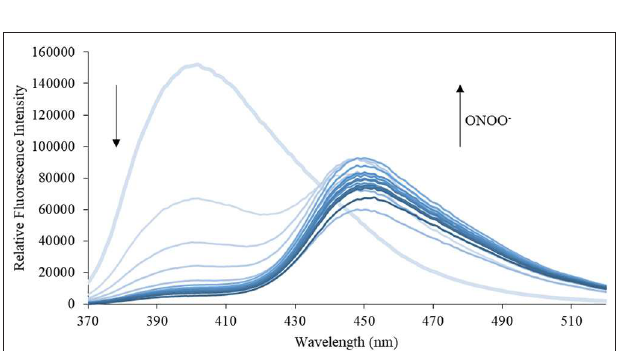
FIGURE 5 | Emission spectra for CM (5 µ M) in the presence of ONOO − (1, 2, 3, 4, 5, 6, 7, 8, 9, 10, 15, 20, 25, 30, 40, 50 µ M) in PBS buffer, pH = 7.4 at 25 ◦ C. Fluorescence intensities were measured with λ ex = 340 (bandwith: 20) nm on a BMG Labtech CLARIOstar ® plate